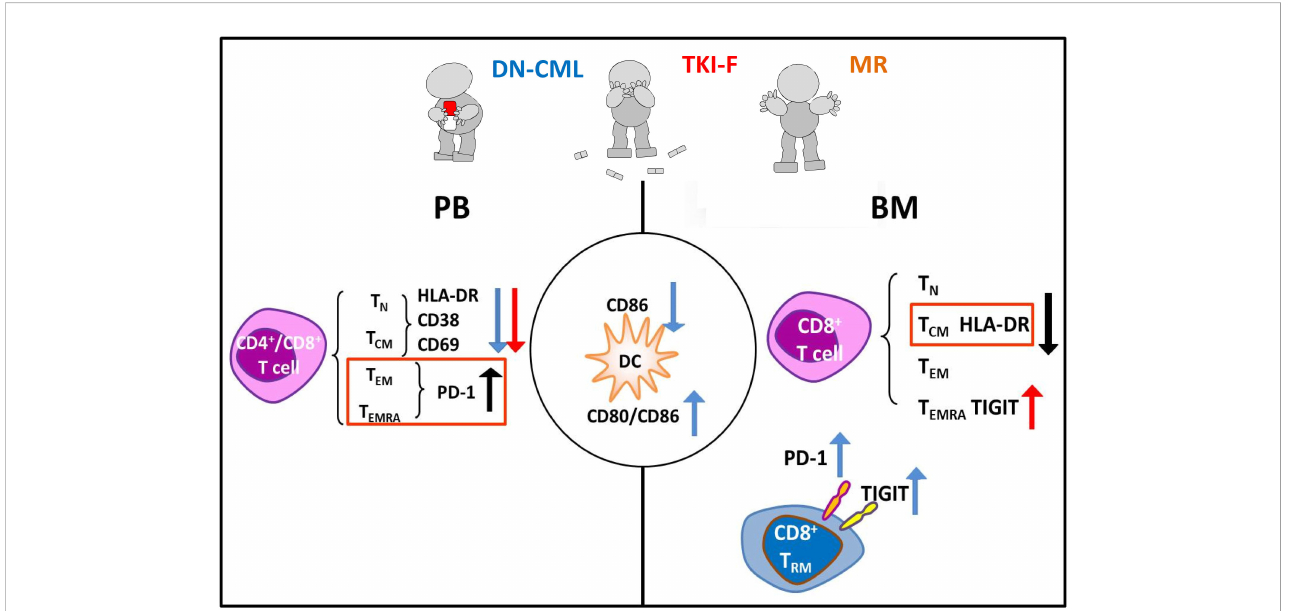
FIGURE 5 Model illustrating the immunophenotypic differences of the T cells subsets in PB and BM in HIs and CML groups. The left and right of the fi gure respectively show the alterations of PB and BM, and the center represents the common change in PB and BM. Blue, red, and black respectively represent alterations in DN-CML, TKI-F, and